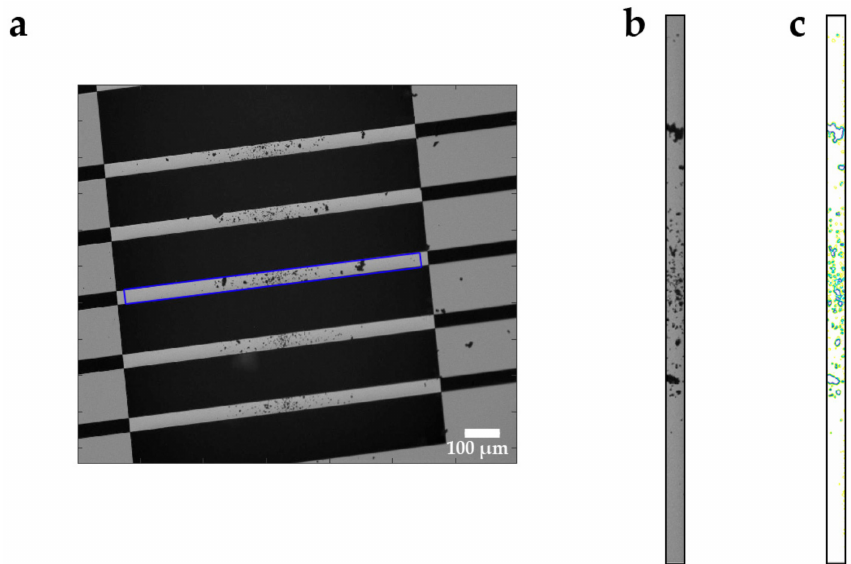
Figure 5. ( a ) Microscopic picture (from the vibrometer’s objective) of the lower part of a microchip showing five coated strings, each 50 µ m in width. The blue frame highlights the string shown in ( b ) The contours of di ff erent levels of this string are shown in ( c ) Yellow represents the first level, green represents the second level, and purple represents the third